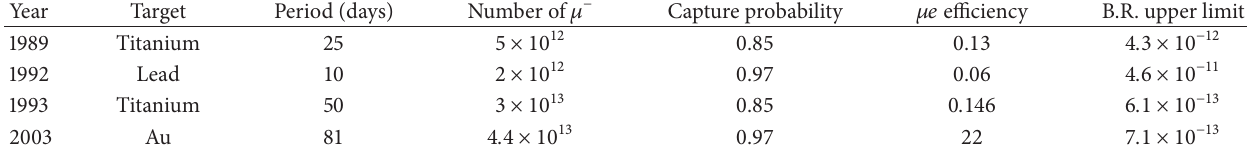
Table 4: The results of the SINDRUM II experiment in various searches for 𝜇 − 𝐴 → 𝑒 − 𝐴 conversion [115, 116].